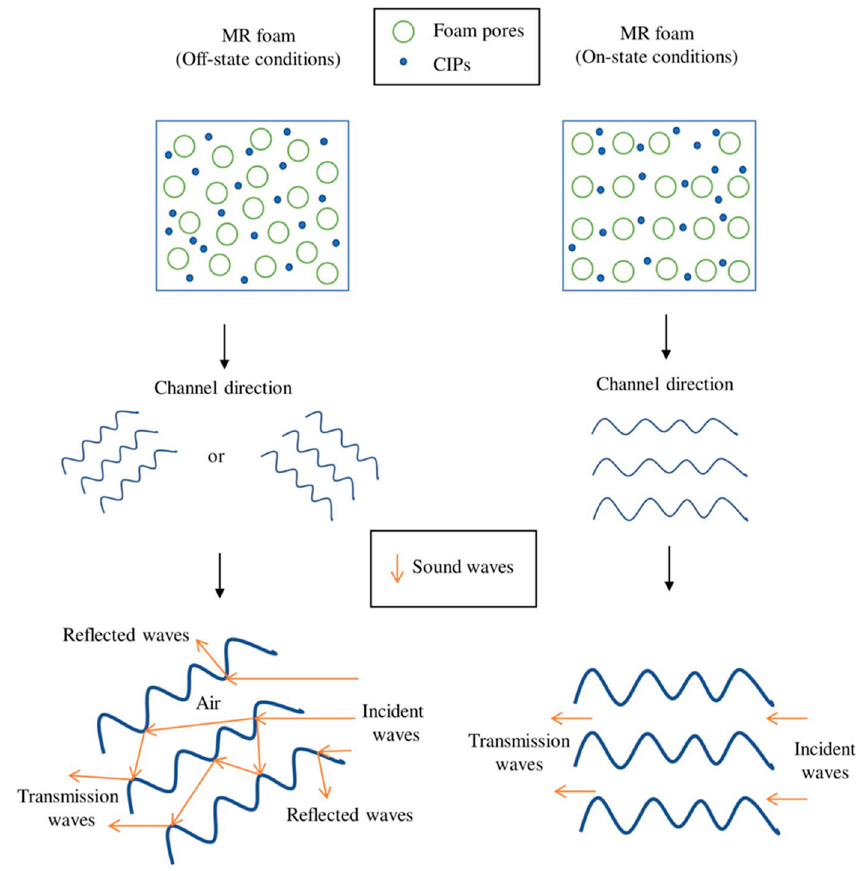
Figure 9. Schematic illustration of the acoustic wave channels in MR foam structures with and without the presence of a magnetic field.